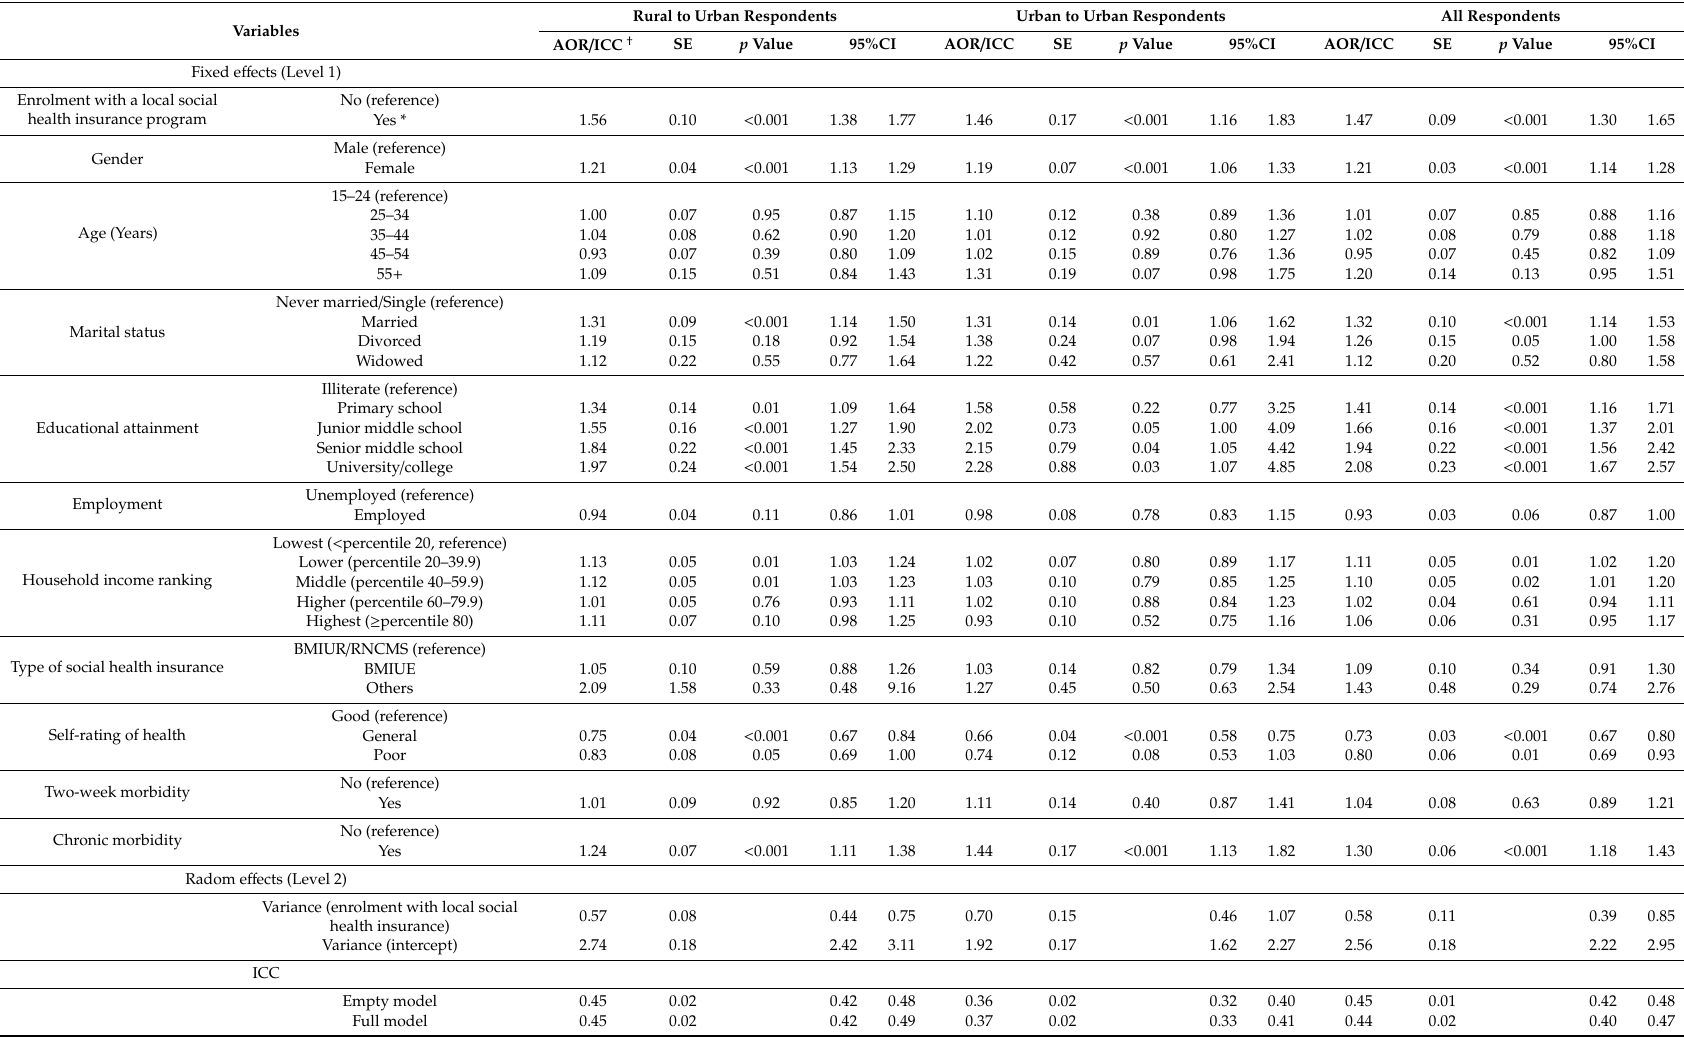
Table 2. Factors associated with the establishment of personal health records: results of two-level logistic regression models.